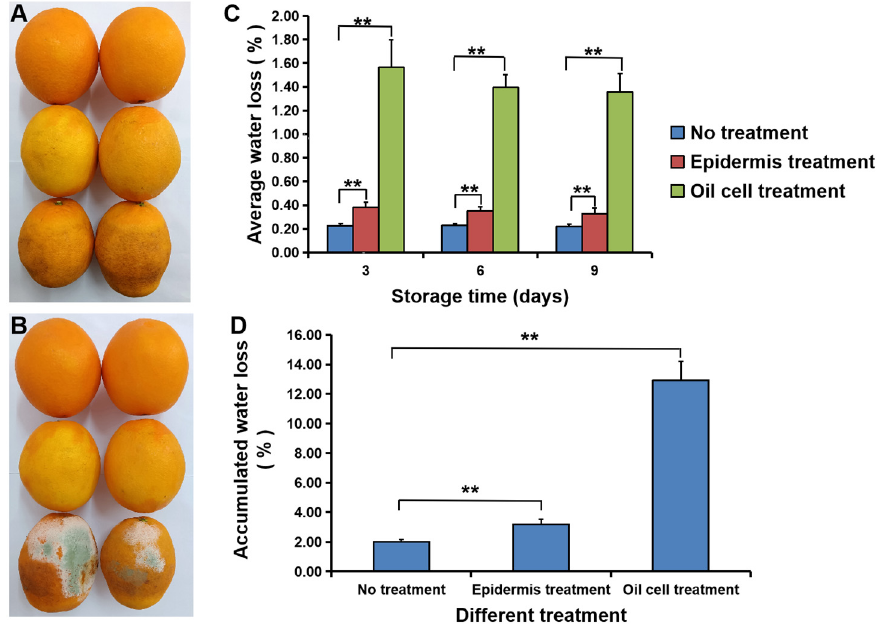
Figure 5. Disruption of pericarp oil cells increased fruit rot and water loss. ( A , B ) the phenotypes of untreated fruit (top), the fruit treated with the oil extract solution (middle) and ruptured pericarp oil (bottom) after 7 d ( A ) and 10 d ( B ) of treatment. ( C , D ) The average water loss per day ( C ) and cumulative water loss ( D ) in untreated fruit, and the fruit treated with the oil extract solution and ruptured pericarp oil. The error bars represent the mean ± SD. **, p < 0.01 ( n = 6).